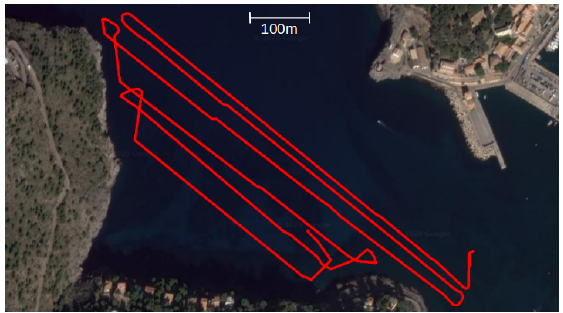
Figure 9. Trajectory followed by the AUV.